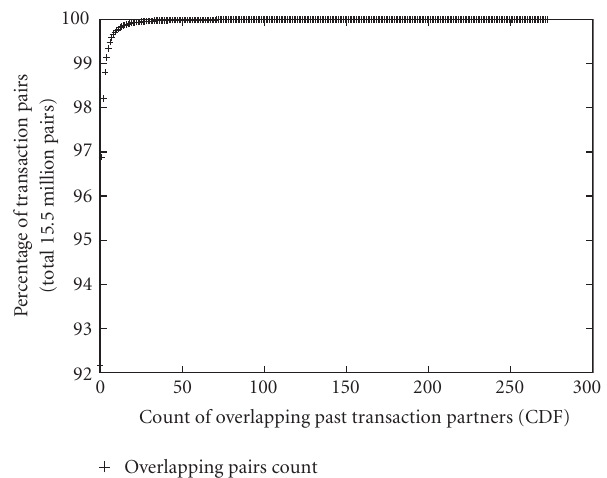
Figure 11: Vulnerability of PeerTrust algorithm to overlapping past transaction histories.